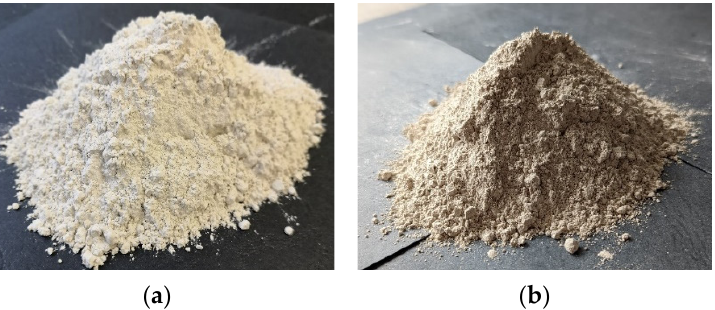
Table 1. Chemical composition of the precursors used.